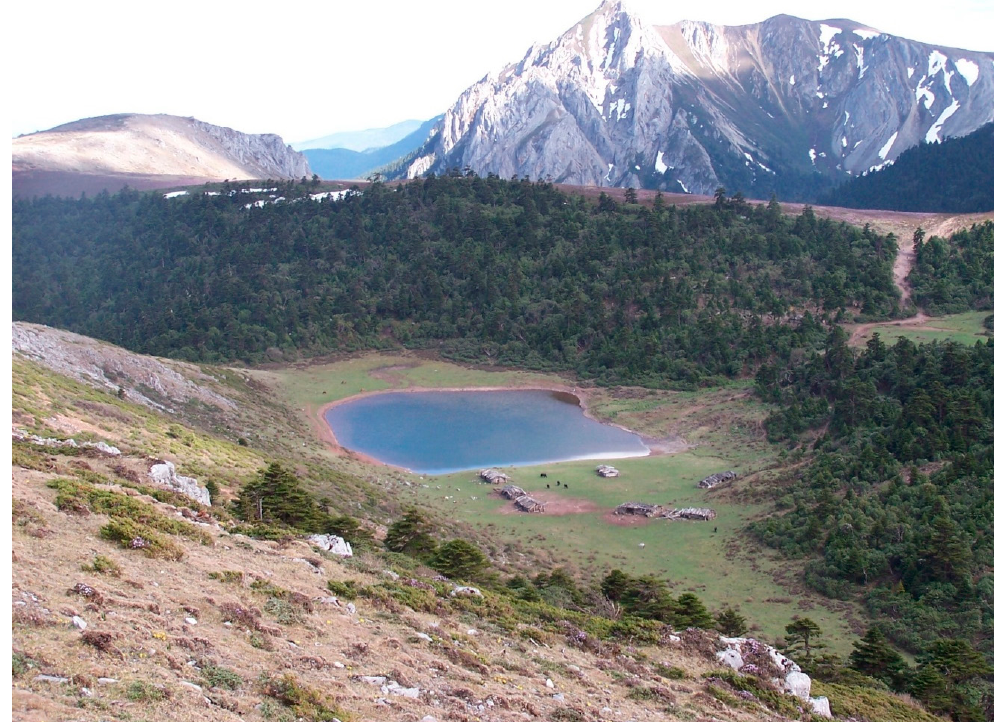
Figure 5. Mount Shika, the male zhidak of Hamugu village and Yak herding huts next to a sacred tarn (glacial pond). (Photo by the author, 2006)